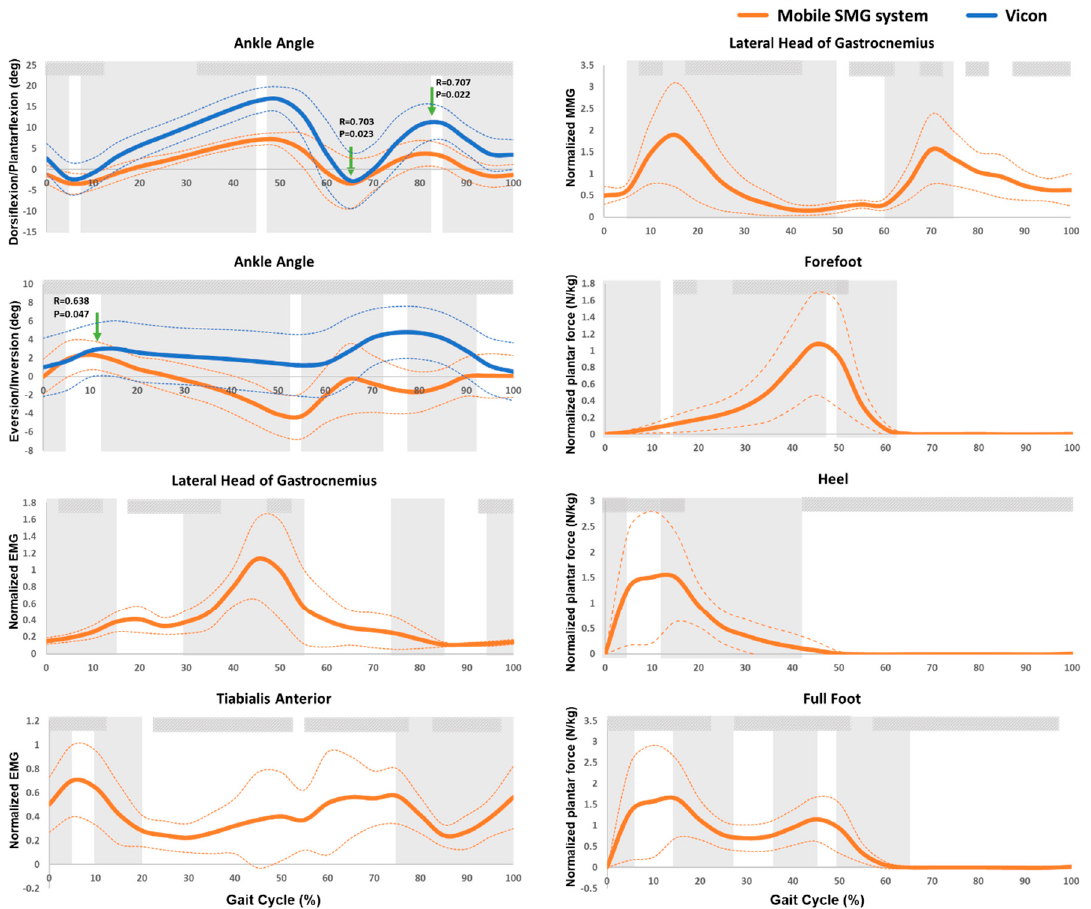
Figure 4. Ankle activities in a gait cycle measured by Vicon and the newly developed mobile SMG system of ten healthy subjects. P: P value; R: Pearson’s correlation coefficient; : significantly high correlation between the Vicon and mobile SMG systems; : significant changes in trend in consecutive 5% intervals; : significantly high correlation in intraclass correlation coefficient (ICC) among three trials; The bolded orange line illustrates the averaged data measured by the mobile SMG system; The bolded blue line illustrates the averaged data measured by the Vicon system; The thin dashed line illustrates the standard deviation (SD) of each corresponding bold line.